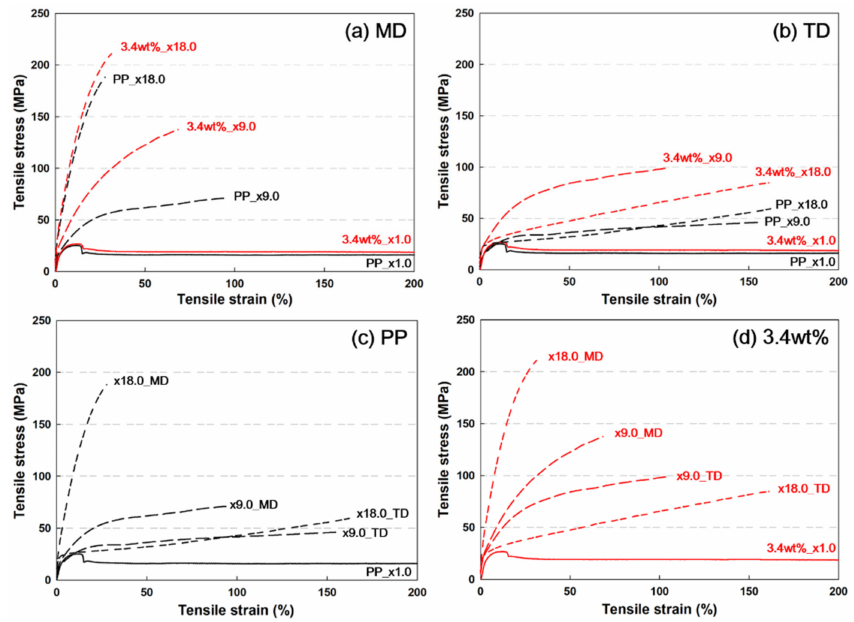
Figure 6. Stress–strain (s–s) curves in ( a ) MD and ( b ) TD of ( c ) PP and ( d ) PP/nanoclay nanocomposite containing 3.4 wt% nanoclay as a function of draw